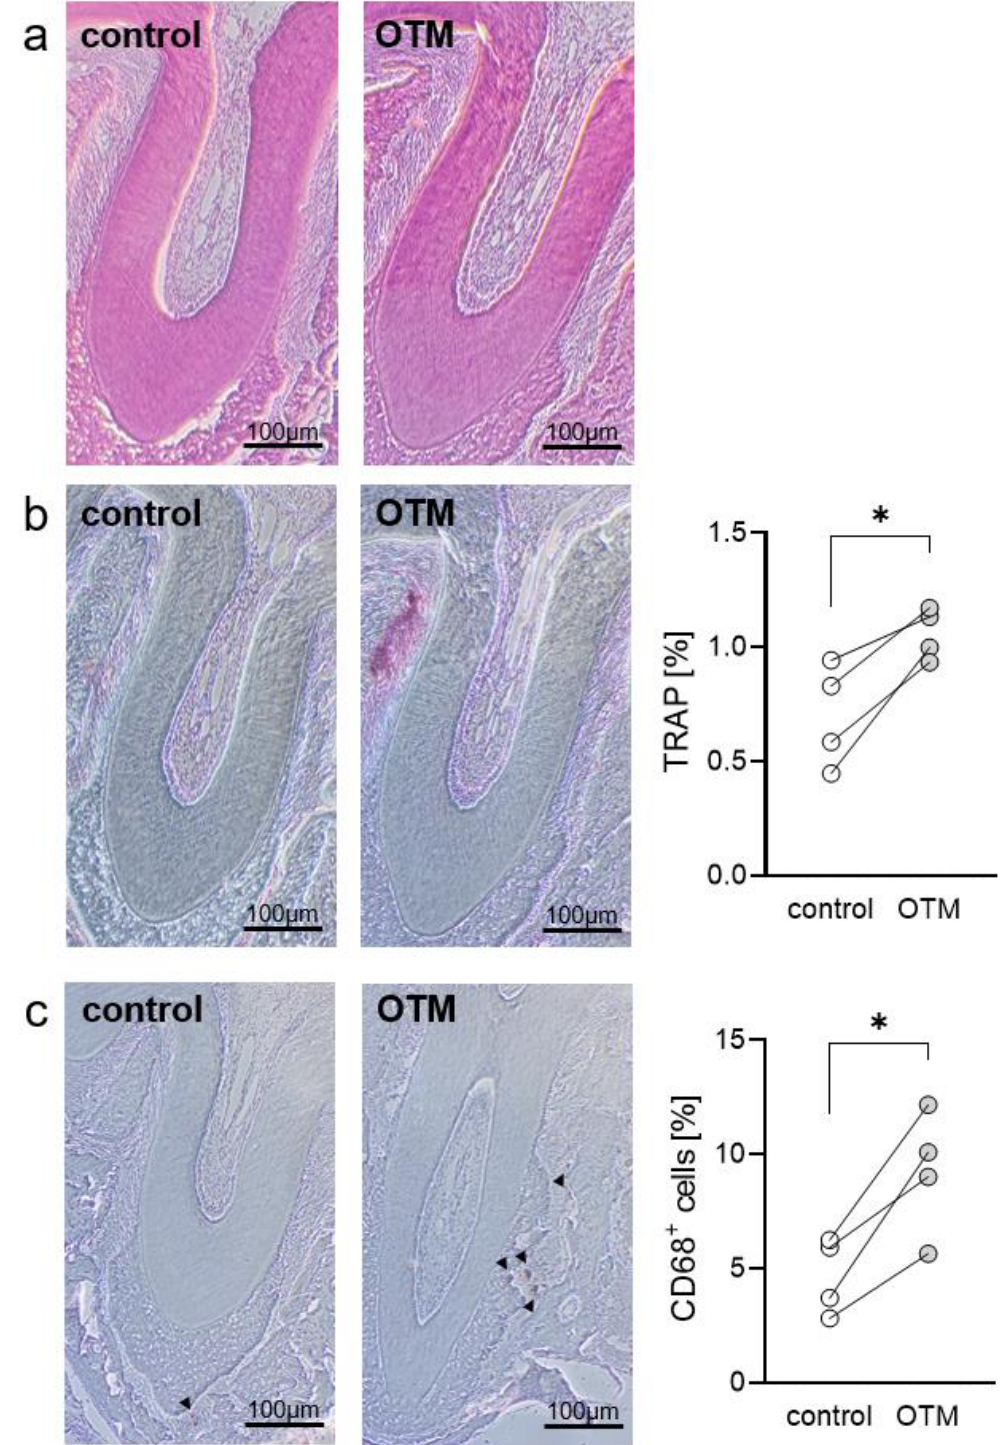
Figure 3. Assessment of relative root resorption ( a ), TRAP + ( b ) and CD68 + area (( c ), black triangles) within the periodontal ligament of the disto-buccal tooth root of the moved upper first left molar ( n = 4). OTM = orthodontic tooth movement. * p < 0.05.